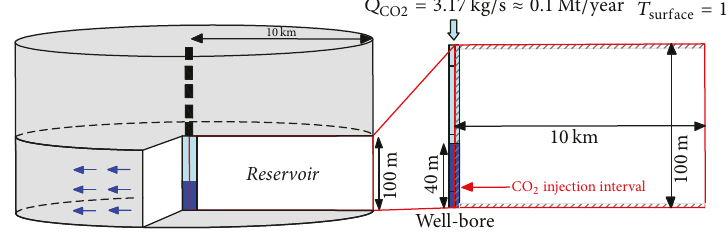
Figure 2: Schematic representation of the 2D radial